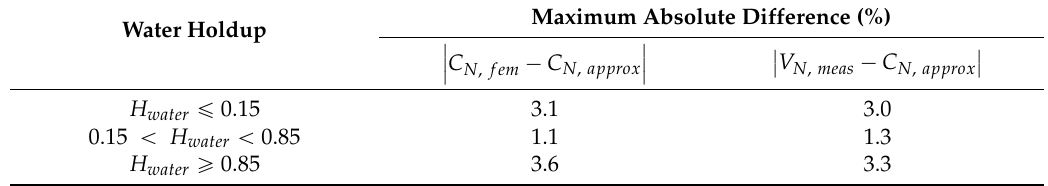
Table 10. Maximum absolute difference of stratified flow.